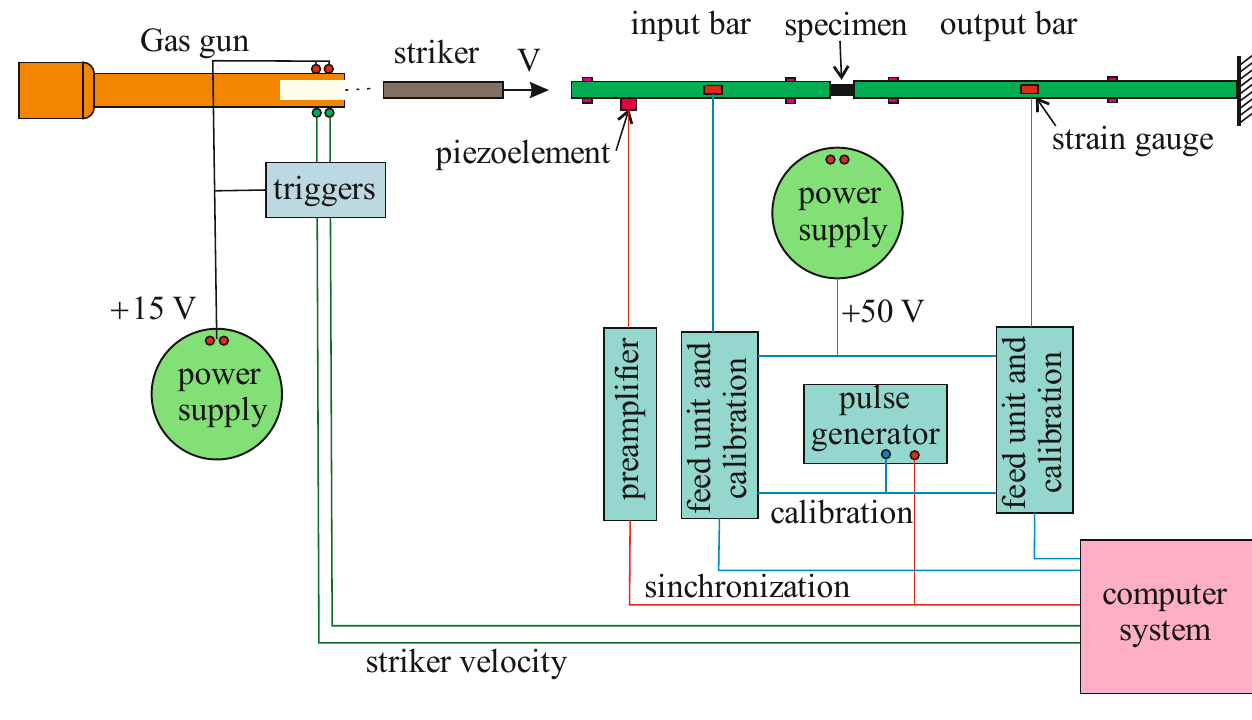
Figure 1. Experimental setup scheme.